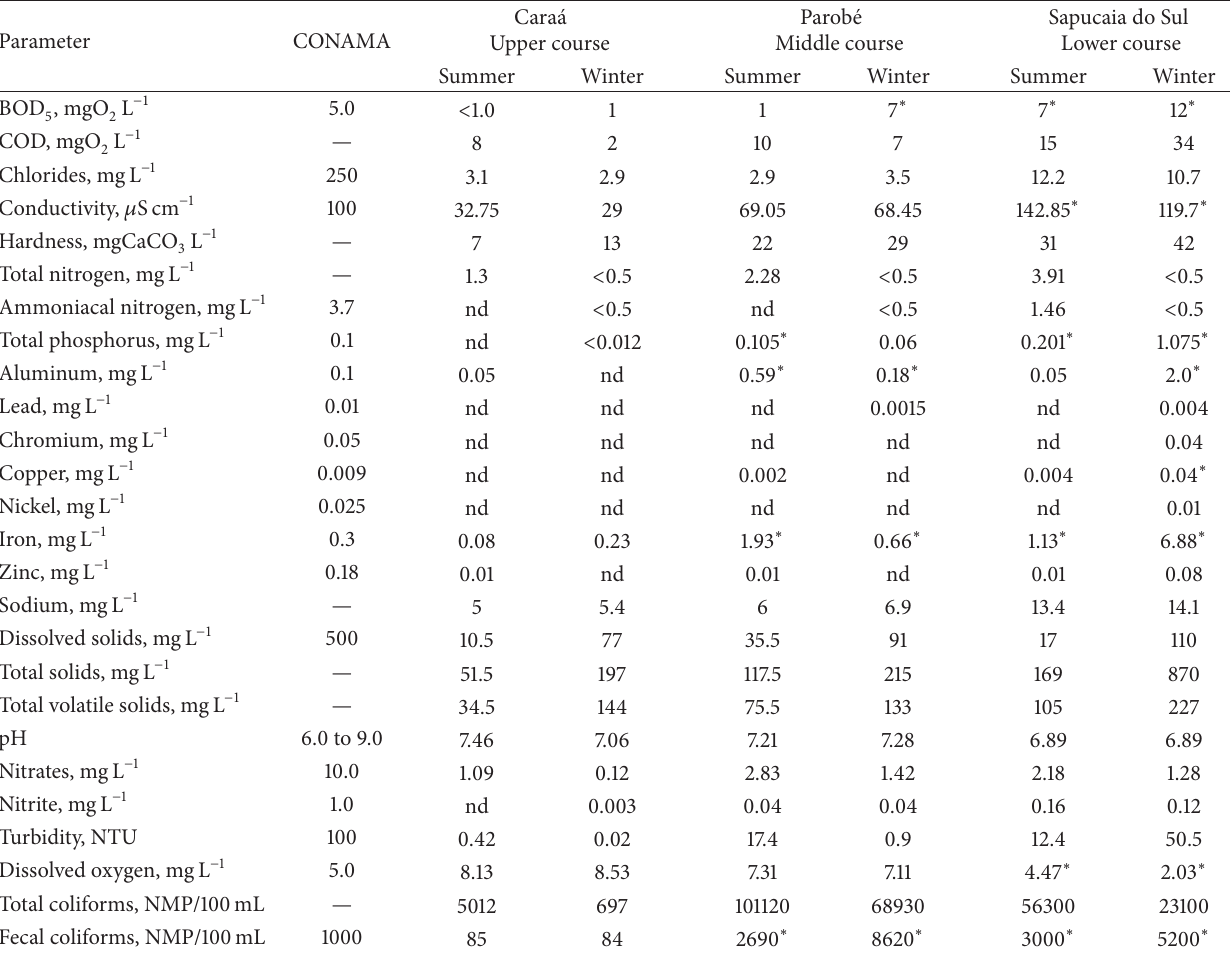
Table 1: Physicochemical parameters of water samples from different sites of Sinos River in the summer and winter of 2008. Parameter CONAMA